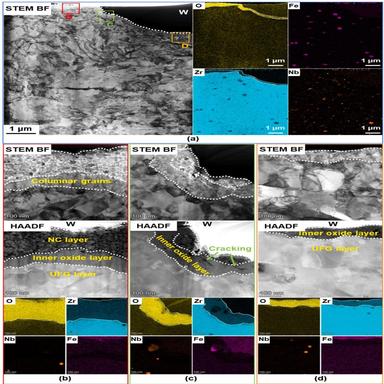
(a) Cross-sectional STEM image and the corresponding EDX maps of the center of worn scar on uncoated cladding and (b-d) Magnified images of region B, region C, and region D.